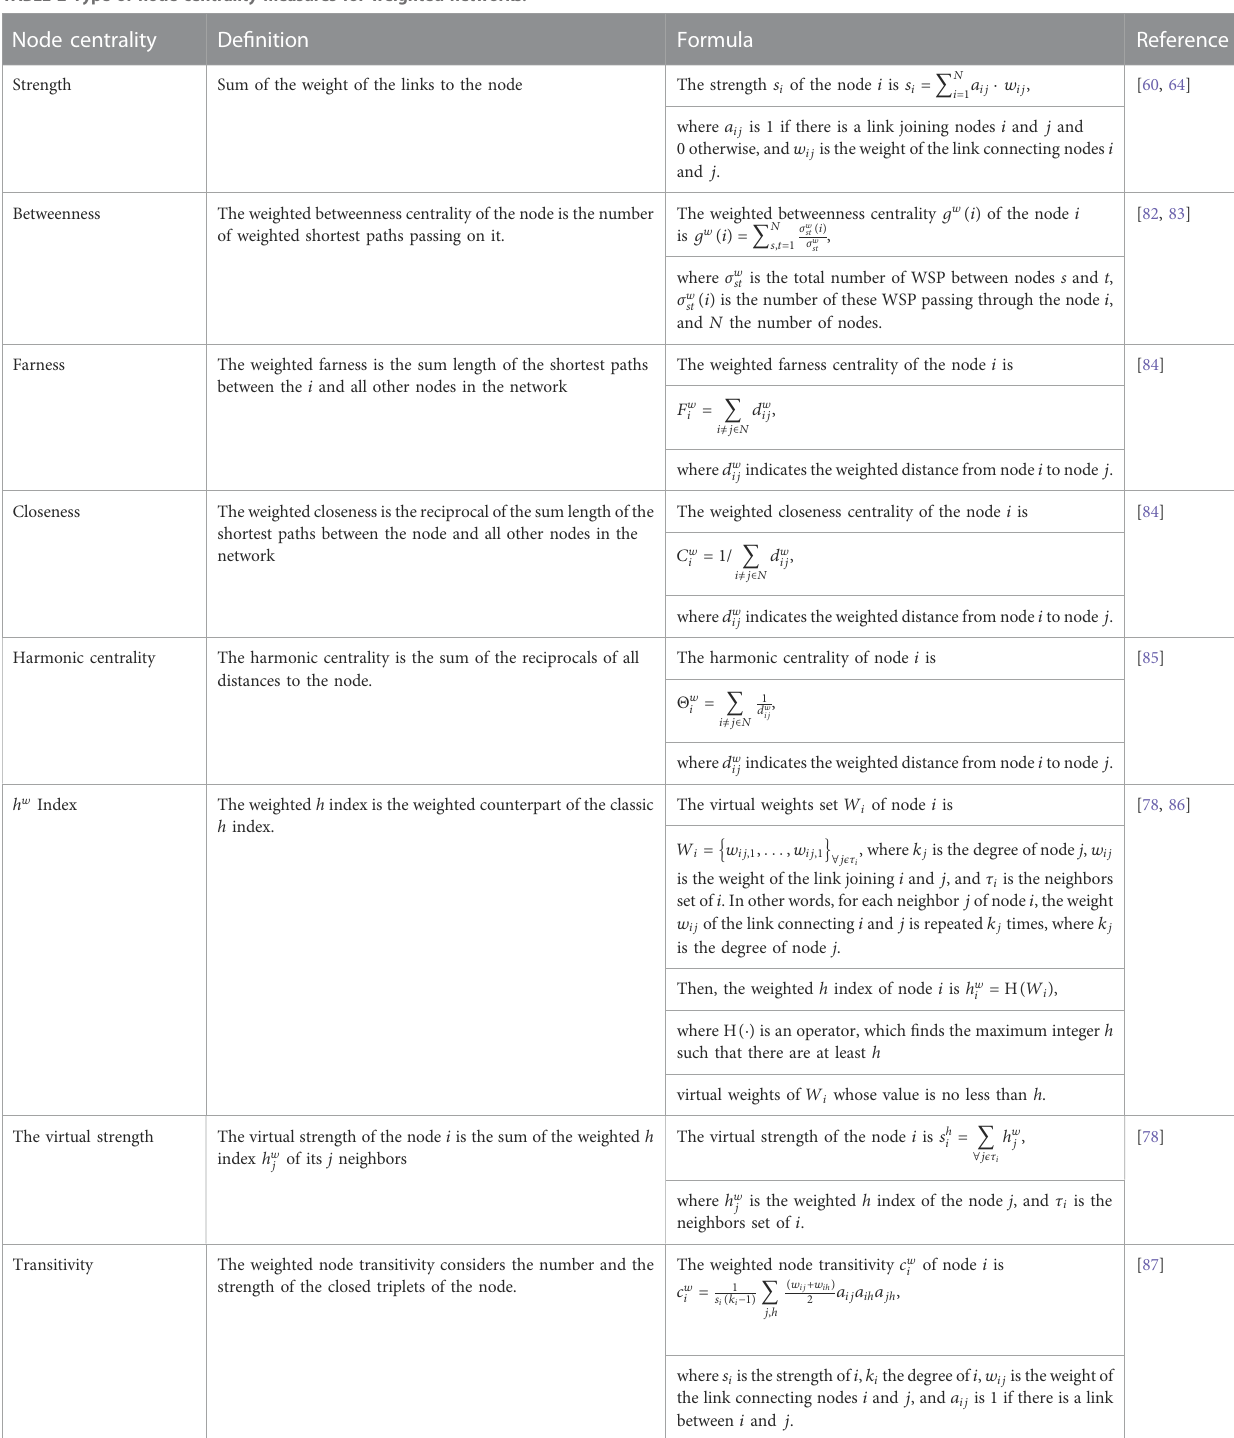
TABLE 2 Type of node centrality measures for weighted networks. Node centrality